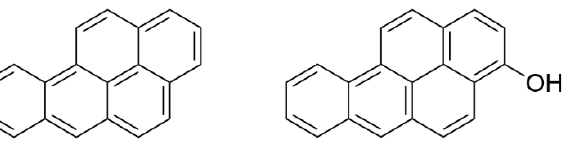
Figure 1. Chemical structure of benzo[ a ]pyrene (BaP, left ) and its metabolite 3-hydroxy-benzo[ a ]py- rene (3-OH-BaP, right